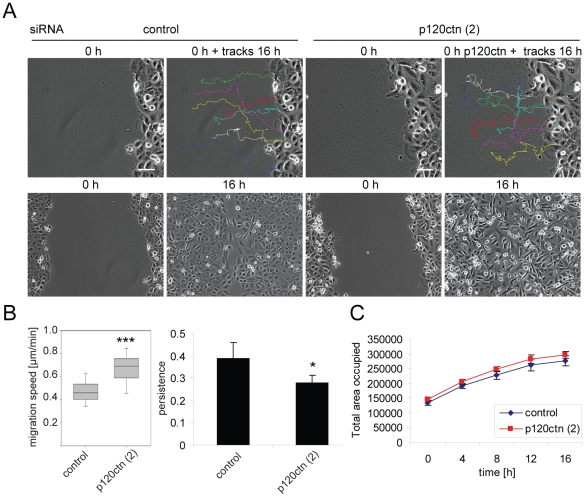
p120ctn depletion decreases directional persistence of cells migrating into a scratch wound.DU145 cells were transfected with siRNAs for p120ctn (p120ctn (2)) and control siRNA (control). After 56 h, a confluent monolayer was wounded using a pipette tip and cells monitored by time-lapse microscopy, acquiring an image every 10 min over a period of 16 h. (A) Phase-contrast images of cells from the first frame of each movie are shown without or with representative tracks of cells (7/image; tracked for 16 h) superimposed (top images). Additionally, scratch wounds of control cells and p120ctn-depleted cells are shown at 0 h and 16 h after wounding (bottom panels). Scale bars  = 50 µm. (B) Migration speed (left) and persistence (right; displacement/track length) were determined. Migration speeds are depicted as box and whisker plots showing median, interquartile range (boxes) and highest and lowest values (whiskers). (C) Area occupied by cells in scratch wounds was determined from phase-contrast images taken at different timepoints from movies. Data are from three different experiments, each carried out in duplicates, analysing 15 cells per field (∼90 cells in total). *p<0.05; ***p<0.001, compared to control and determined by Student's t-test.